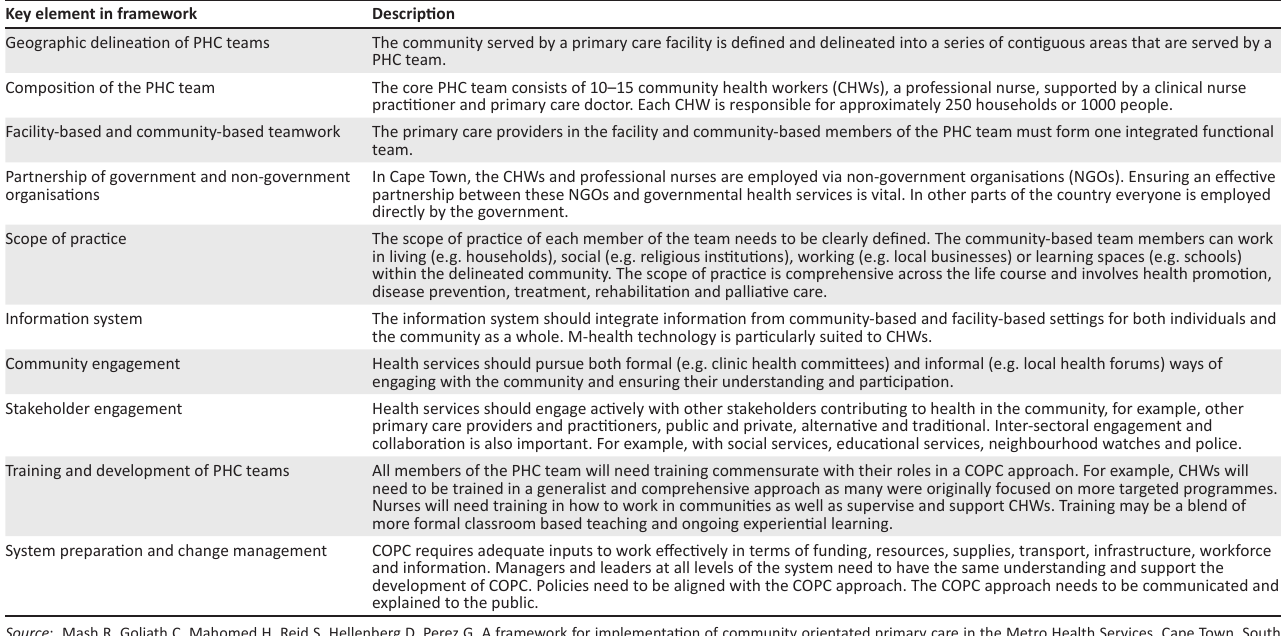
TABLE 2: The Cape Town framework for implementation of community-orientated primary